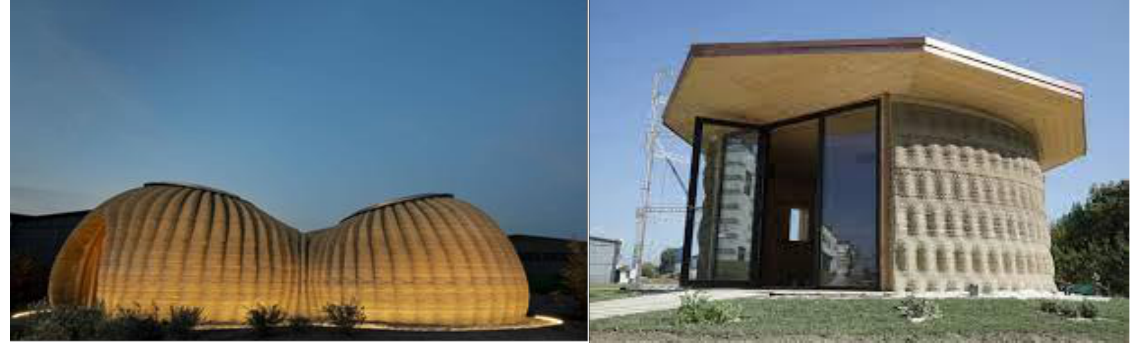
Figure 8: Project TECLA (Mario Cuccinella Architect) and Project GAIA